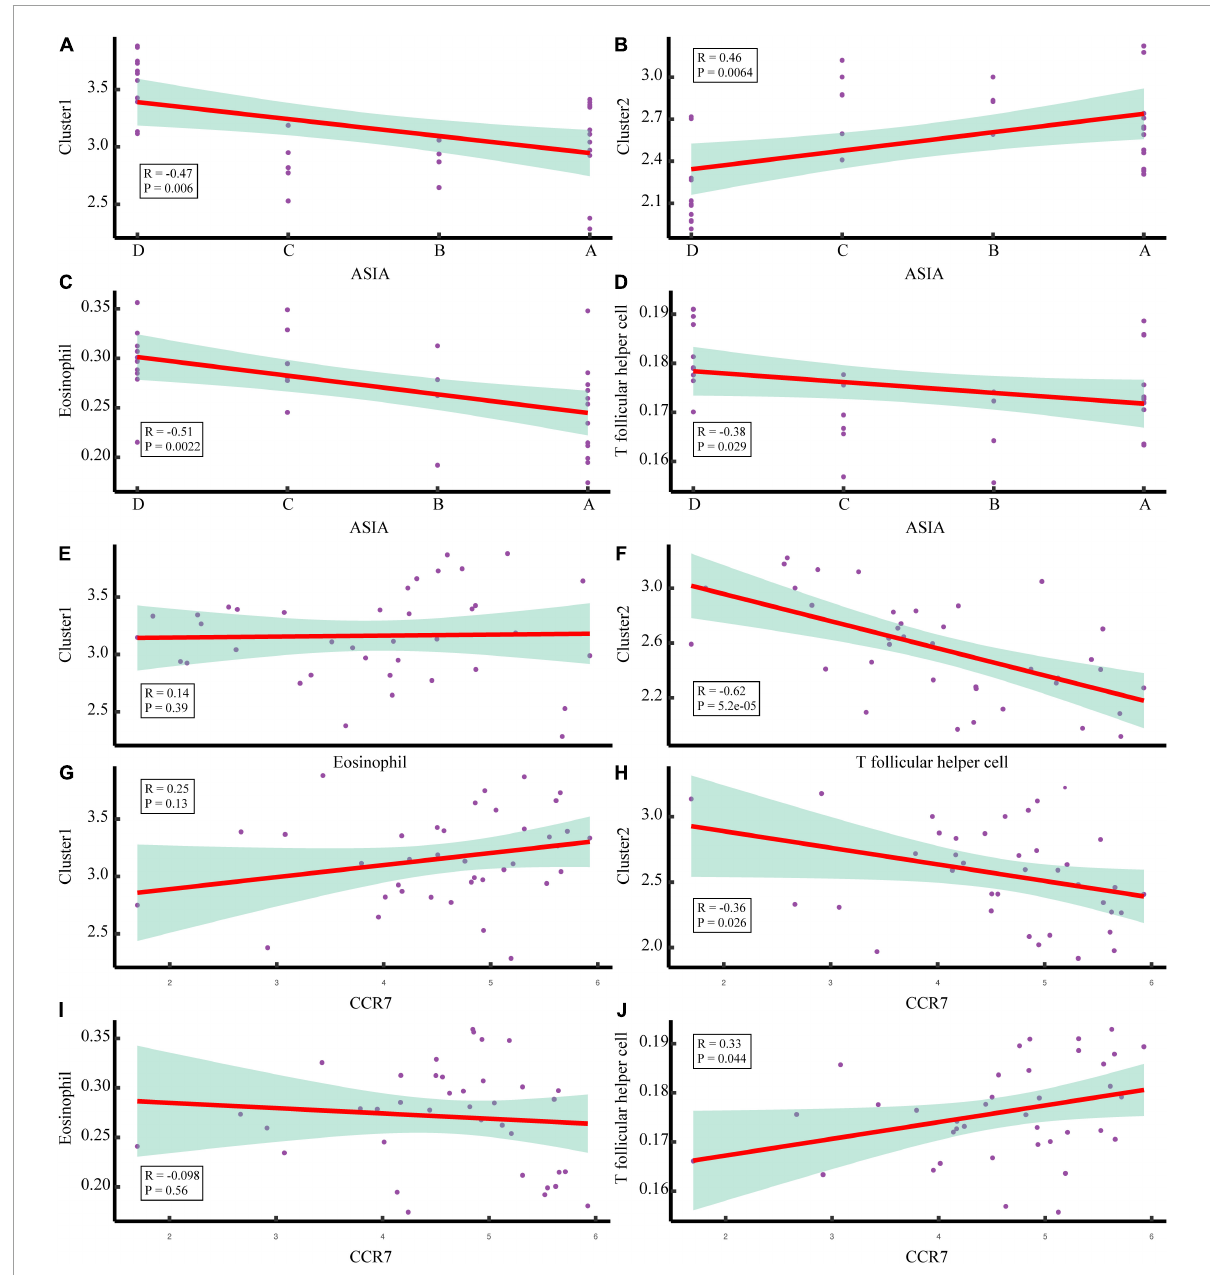
FIGURE9 Correlation analysis of the molecular subtypes of acute SCI. (A,B) Scatter plot of correlation analysis between ASIA classification and the acute SCI molecular subtypes Cluster 1 and Cluster 2. (C,D) Scatter plot of correlation analysis between ASIA grading, eosinophils, and T follicular helper (Tfh) cells. (E) Correlation analysis of the acute SCI molecular subtype Cluster 1 and eosinophils. (F) Correlation analysis of the acute SCI molecular subtype Cluster 2 and Tfh cells. (G,H) Scatter plot of correlation analysis between CCR7 and the acute SCI molecular subtypes Cluster 1 and Cluster 2. (I,J) Scatter plot of correlation analysis between CCR7, eosinophils, and Tfh cells. R denotes the correlation coefficient, and P denotes the p